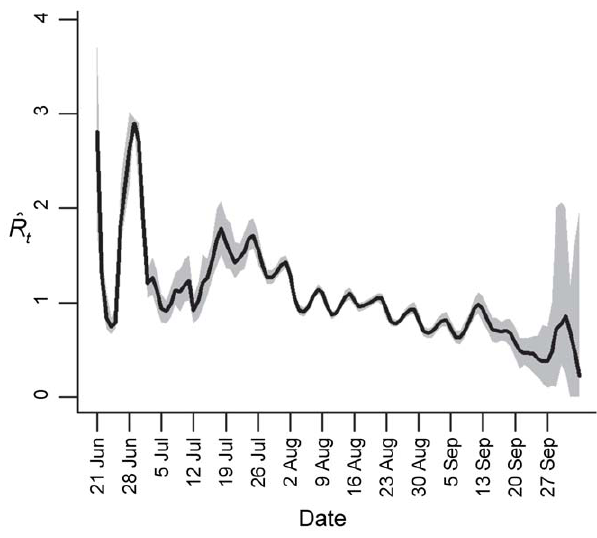
Figure 4. Temporal variation in the mean effective reproduc- tive number ( ^ RR t ) of influenza A(H1N1)pdm09 in South Africa, June 15 to October 4, 2009 (method 3).